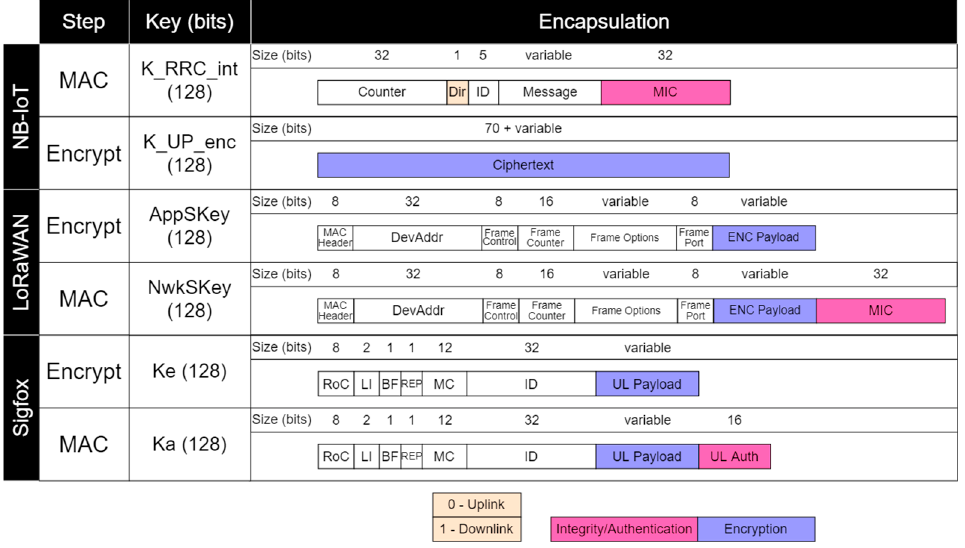
Figure 6. IoT network architectures for wide-area and their security protocols.